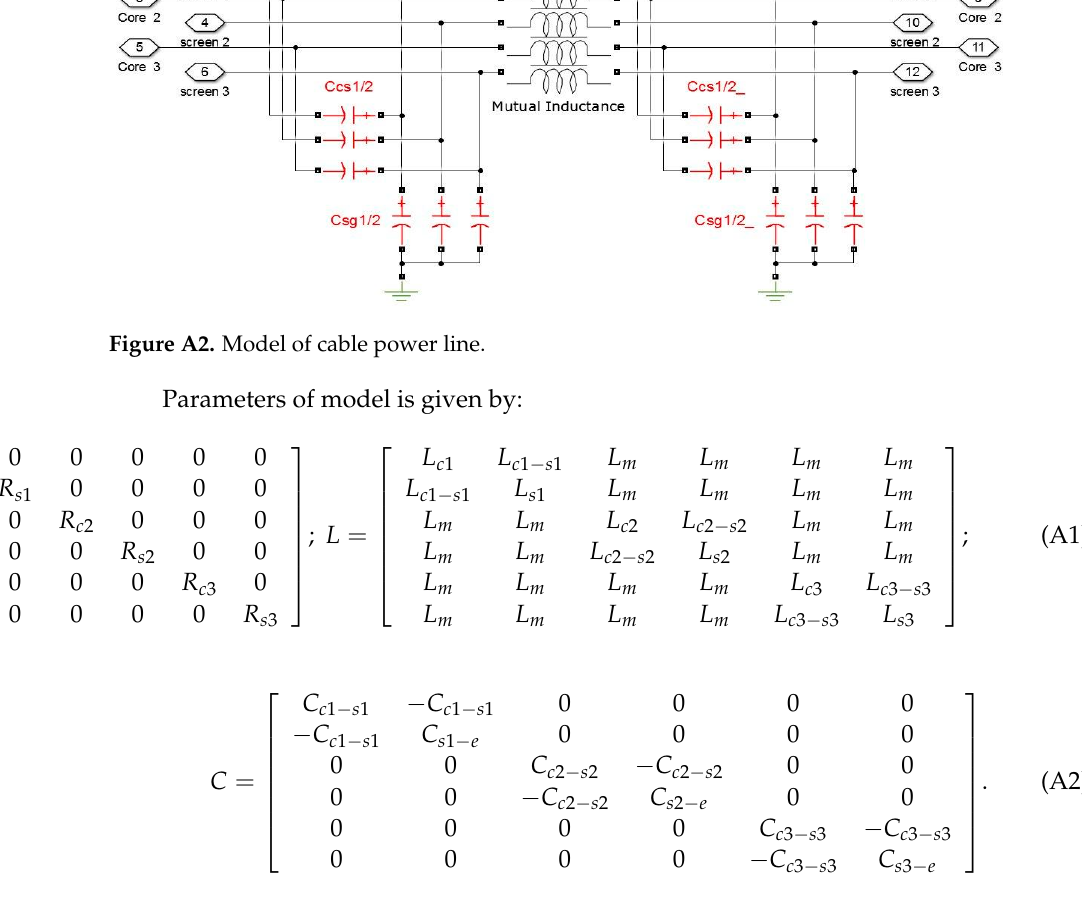
Figure A3. Simplified image of the XLPE-cable layers structure.